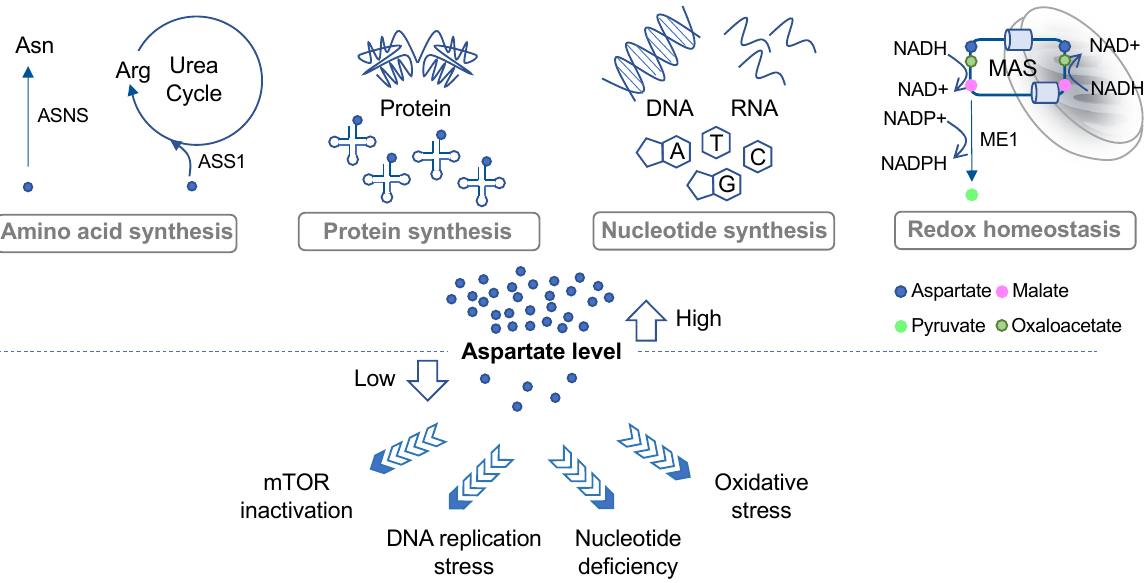
Figure 1. Roles of aspartate in cell proliferation and survival. The diagram outlines the major biosynthetic and redox pathways in which aspartate is required and the potential consequences when aspartate level is insufficient. ASNS, asparagine synthase; ASS1, argininosuccinate synthase 1; MAS, malate–aspartate shuttle; ME1, malic enzyme 1.